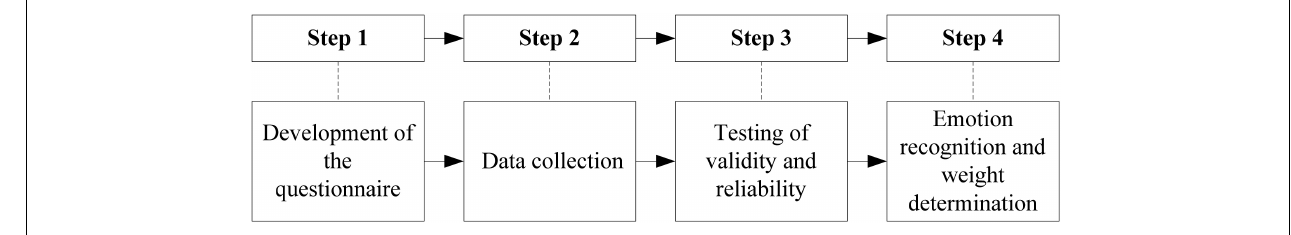
FIGURE 1 | Research steps.